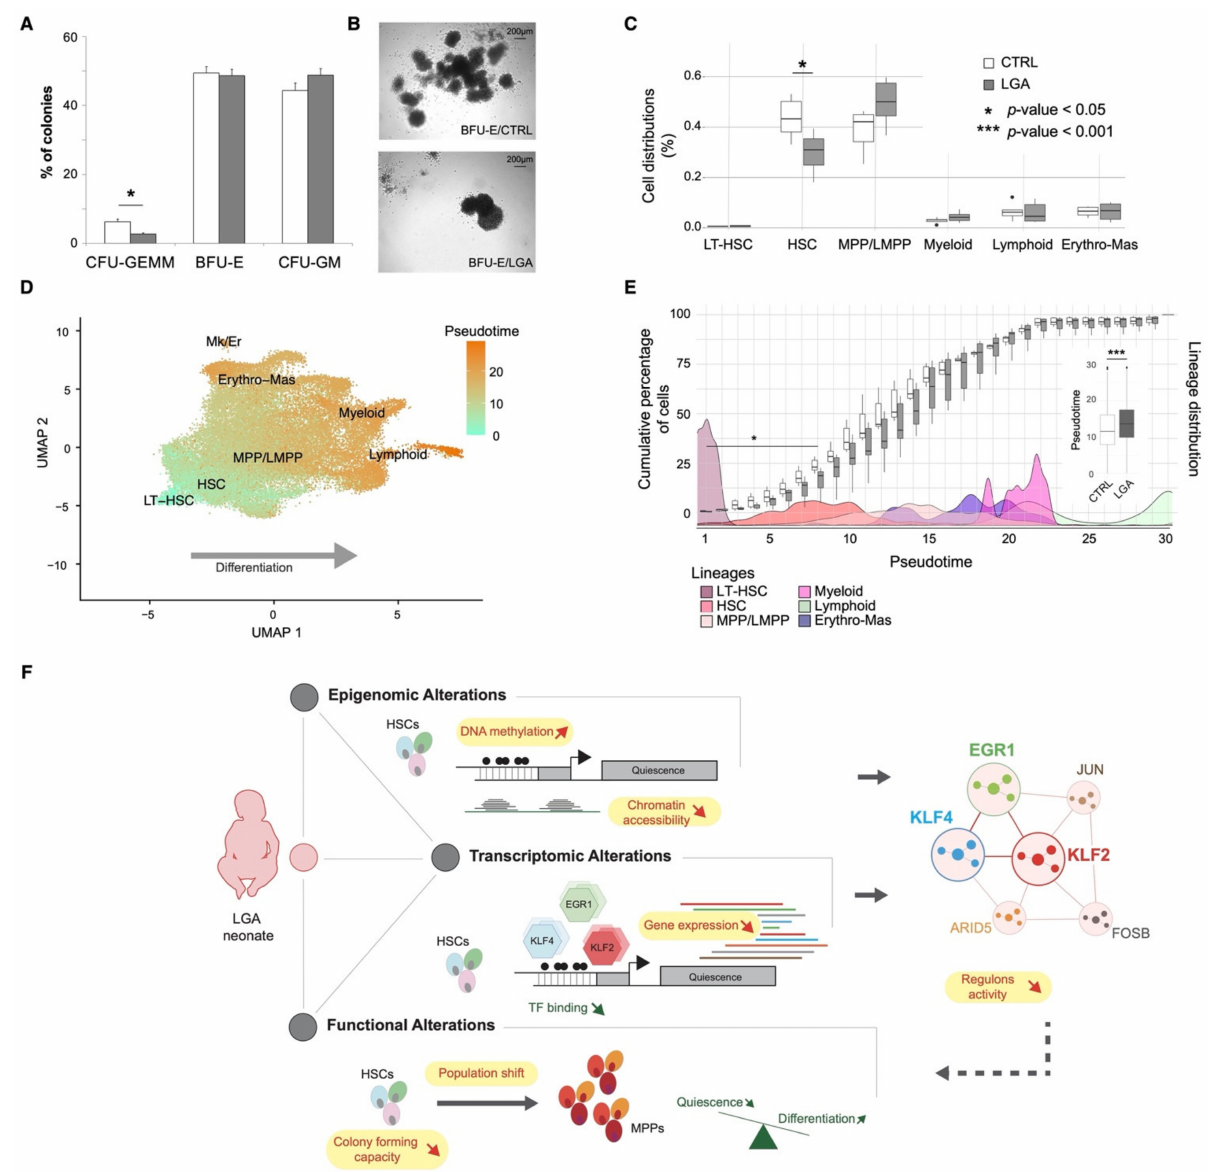
Figure 7. LGA is associated with decreased expansion capacity and an HSC shift toward more dif- ferentiated cells. ( A ) Bar plot representing colonies distribution after CFU assays. ( B ) Representative capture of colonies’ morphological differences found in CTRL and LGA. ( C ) Boxplots representing the cell distribution across hematopoietic main lineages in CTRL and LGA. ( D ) UMAPs represent- ing pseudotimes across lineages. ( E ) Box plots representing the cumulative percentage of cells per pseudotime in CTRL and LGA. Boxplots in the vignette represent overall pseudotime distribution in CTRL and LGA. Density plots correspond to cell populations distribution across pseudotimes. ( F ) Model recapitulating the influence of LGA on the hematopoietic compartment. (LT-HSC, long- term hematopoietic stem cell; HSC, hematopoietic stem cell; MPP, multipotent progenitor; LMPP, lymphoid-primed multipotent progenitors; Erythro-Mas, erythroid and mast precursor; Mk/Er, megakaryocyte and erythrocyte; DC, dendritic cell; CFU-GEMM, common myeloid progenitors; BFU-E, erythroid progenitors; CFU-GM, granulocyte-macrophage